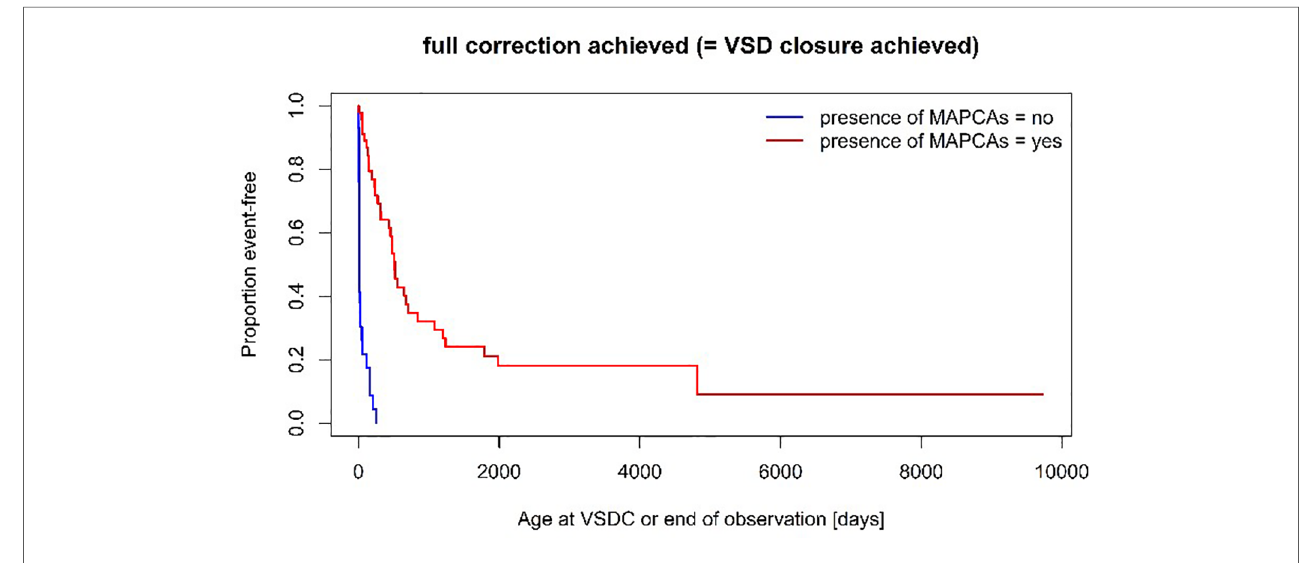
FIGURE 2 Time to VSD closure (log-rank test: p